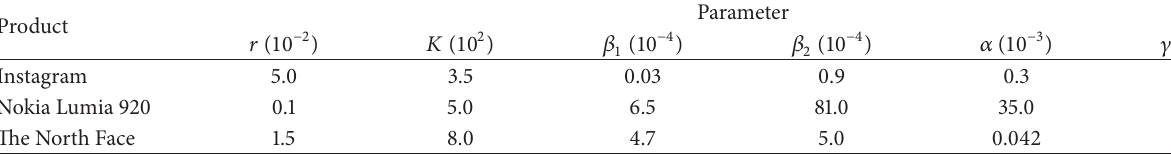
Table 1: Estimated parameter values.